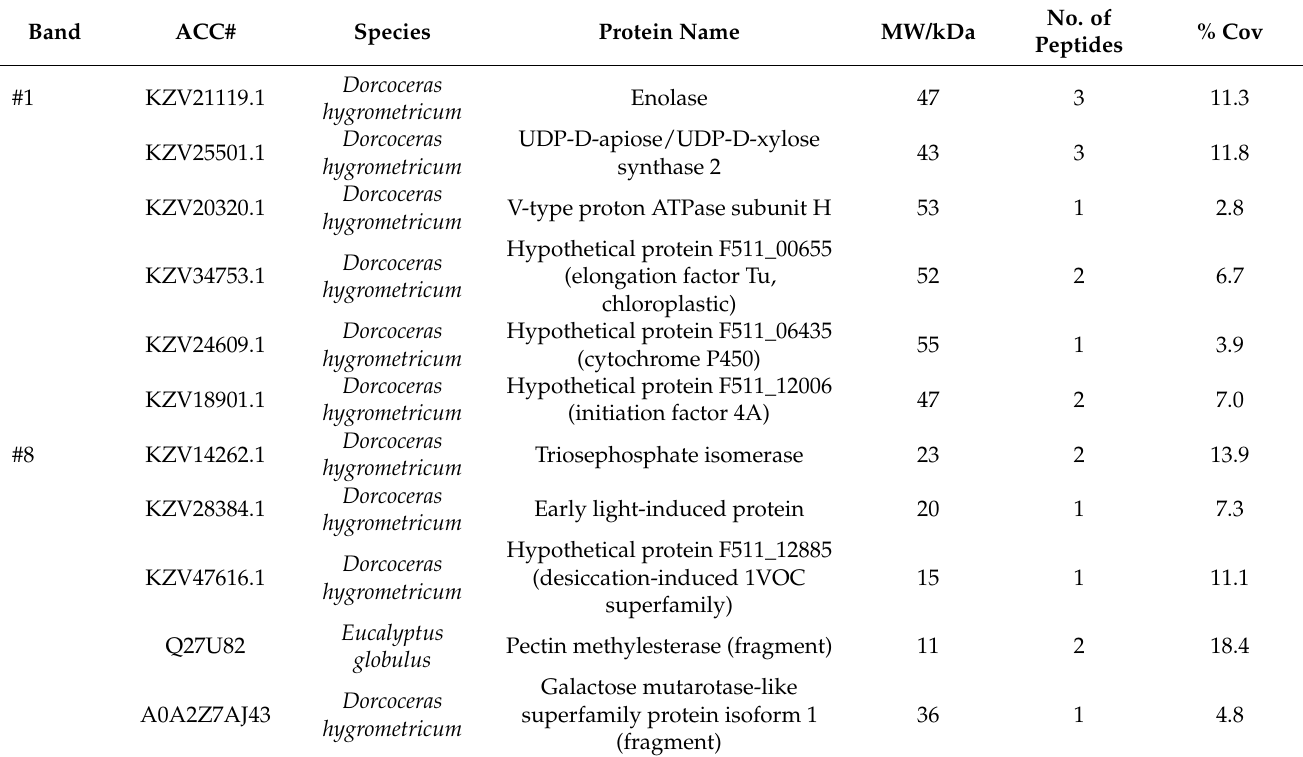
Table 1. Proteins identified in Band 1 (48 kDa) and Band 8 (14 kDa) by LC-MS/MS analysis from desiccated (8% RWC) shade H. rhodopensis plants that are not present in